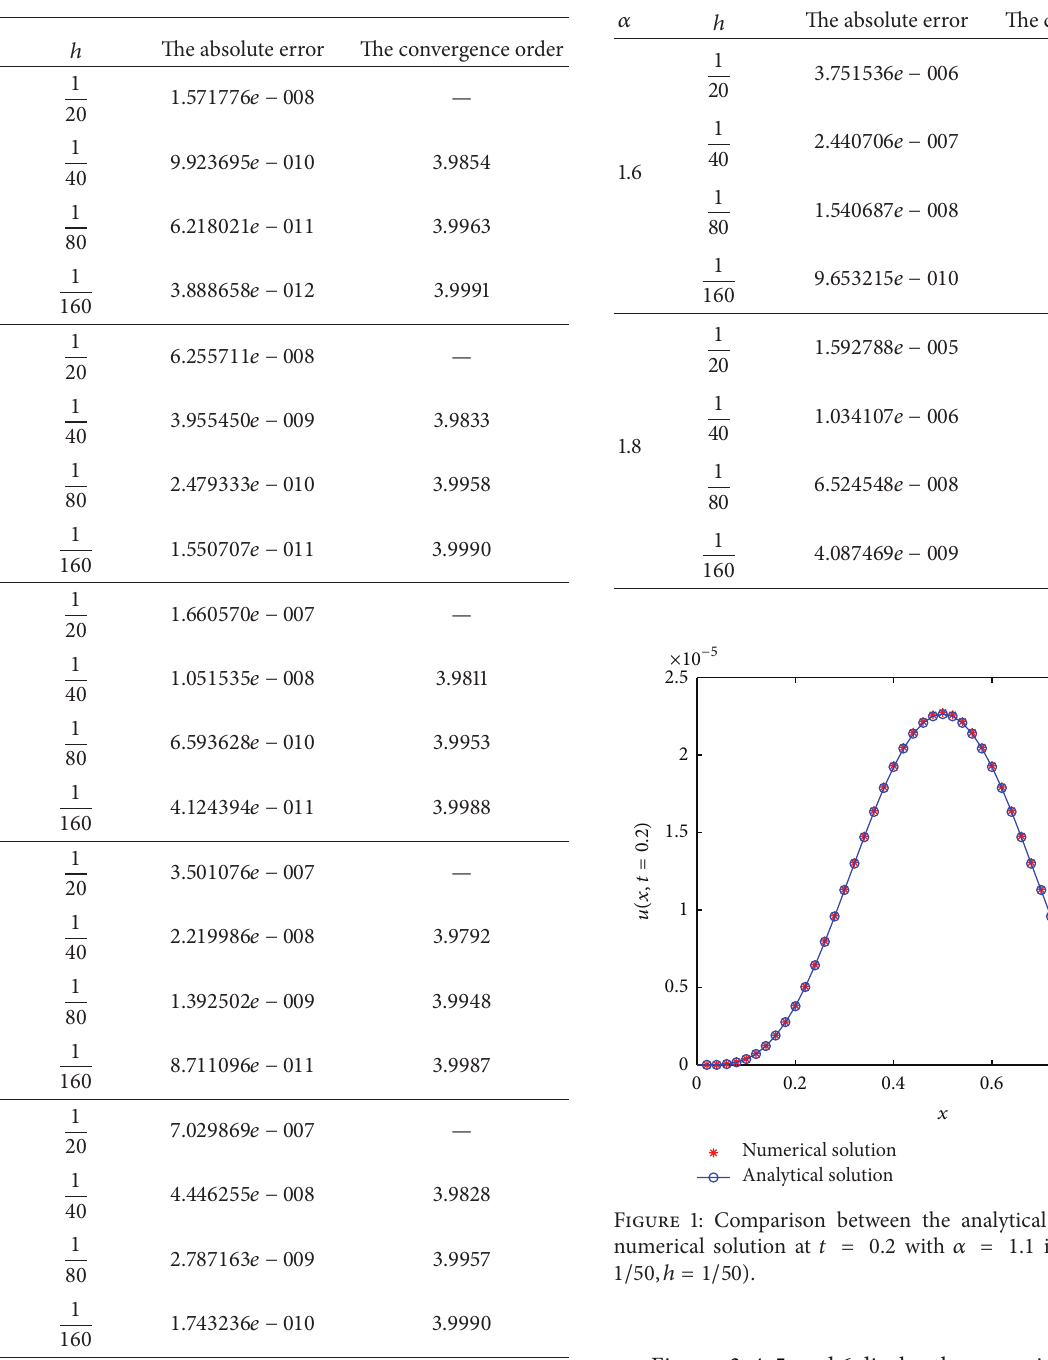
Table 2: The absolute errors and convergence orders of Example 2 by numerical scheme (47).